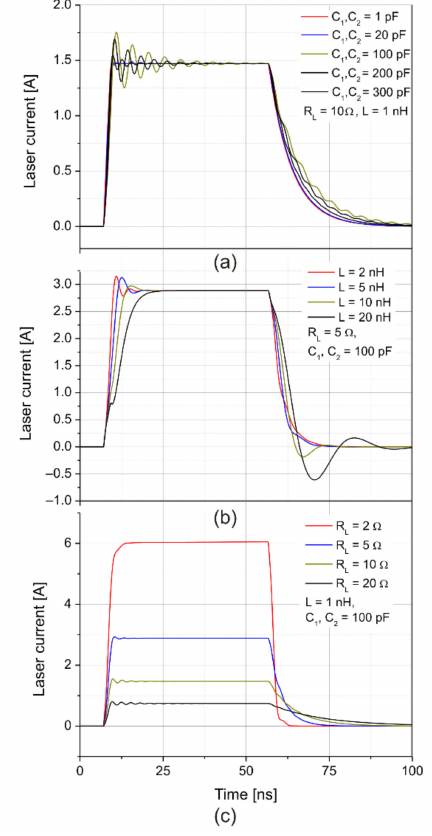
Figure 3. Simulation results of the modulator for different lasing structure electrical parameters: capacitance ( a ), inductance ( b ), and resistance ( c ).